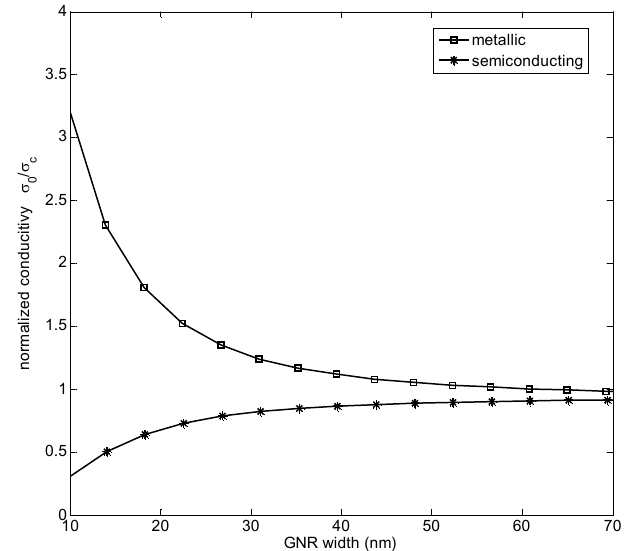
/ σ , for metallic and semiconducting armchair GNRs at 300 0 c